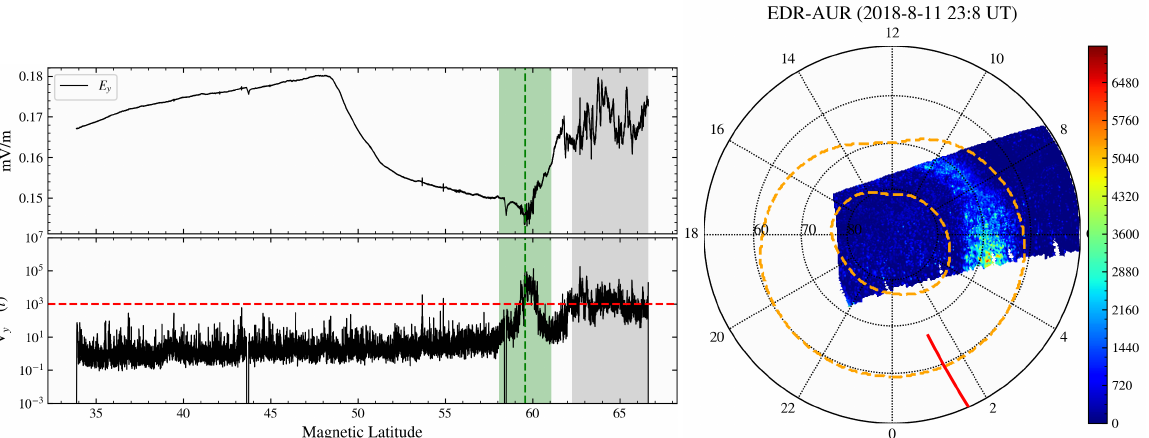
Figure 13. Same as Figure 7, except for orbit 2898. Negative detection, nightside northern Hemisphere. Crossing not detected because of short latitudinal interval (see text).